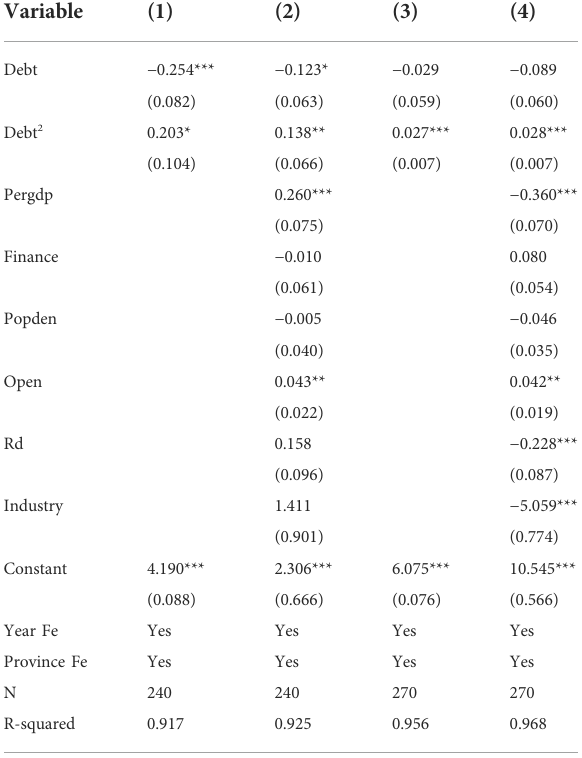
TABLE 3 The robustness